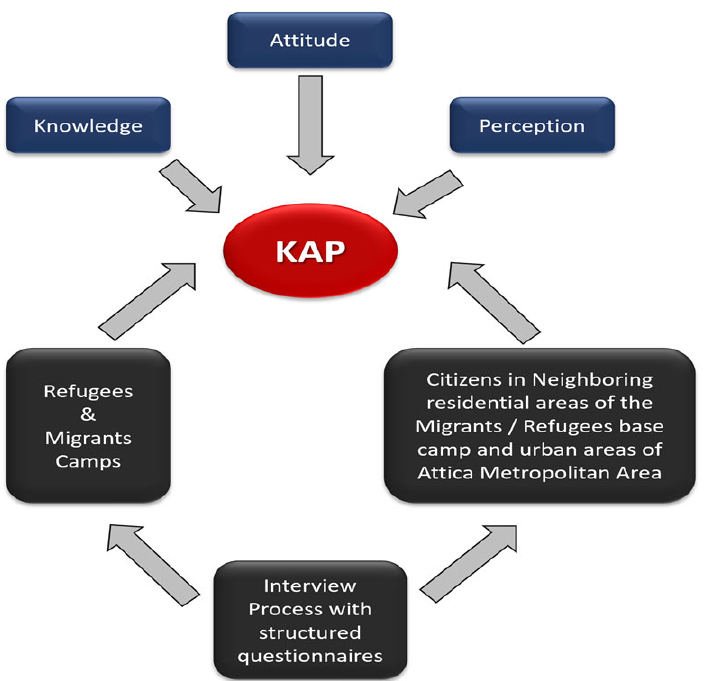
Figure 2. The implementation of KAP approaches in different citizenship contexts.